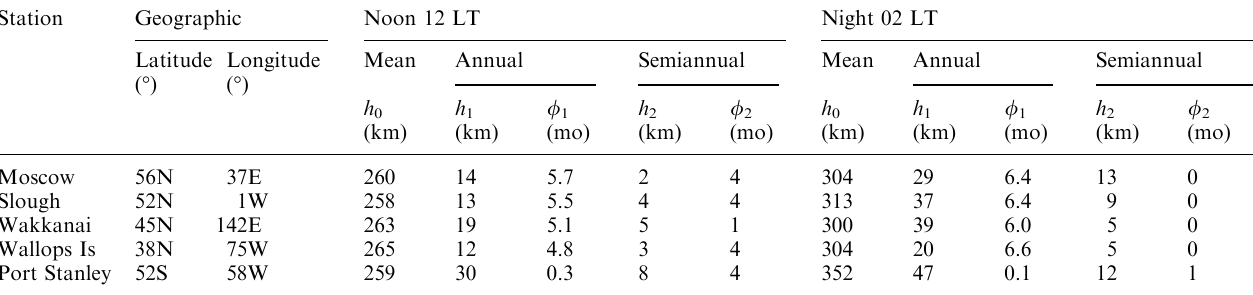
Fig. 4. Day (10–14 LT) and night (22–02 LT) periodograms of h mF2 for five stations = 140 10.7